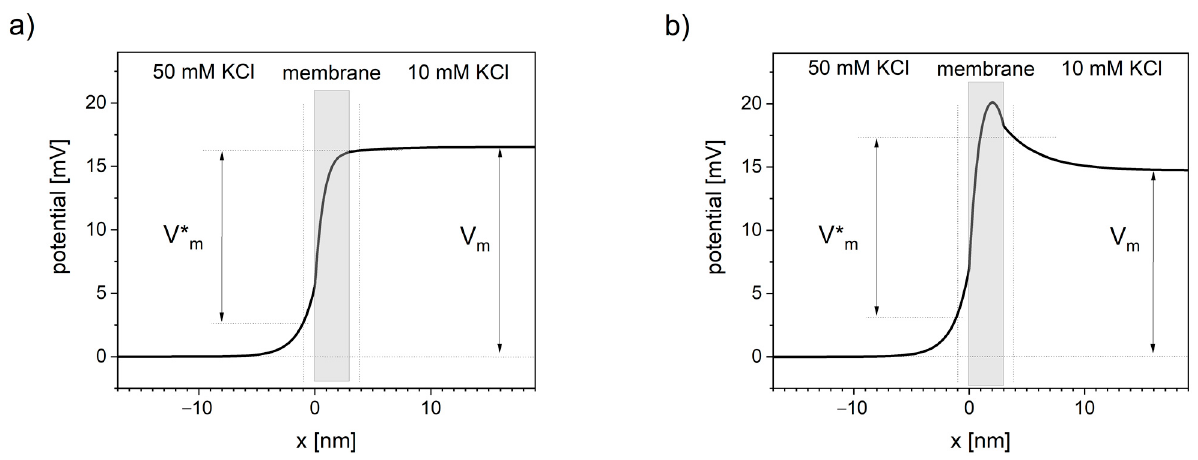
Figure 2. Distortions in transmembrane potential invisible to patch-clamp measurements. Thick black line represents the voltage profile across the system of a cation-selective membrane between two solutions calculated using NPP model. V m is the transmembrane voltage measured in patch-clamp technique, away from the membrane. V* m is the transmembrane voltage sensed by the channel voltage sensor. Vertical dotted lines represent the approximate sub-membrane locality that primarily affects the channel voltage sensor (assumed at 1 nm distance from the membrane). ( a ) Concentration of negative charge in the membrane equals 10 nM, ( b ) concentration of negative charge in the membrane equals 0.